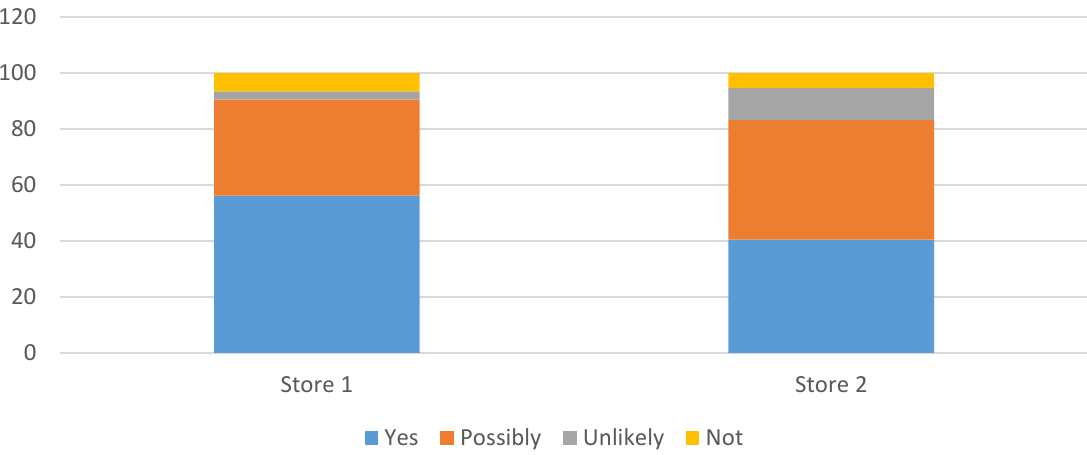
Source: Compiled by the authors according to consumer